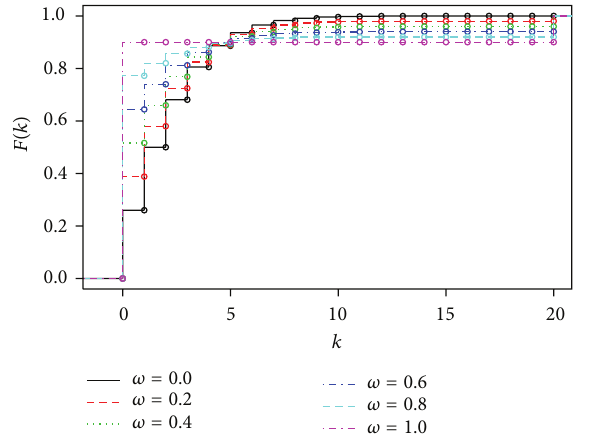
Figure 2: The approximated VaRs of 𝑆 1000 , by confidence level 𝛼 and the limiting correlation 𝜔 , under the 𝛽 -ICM model.